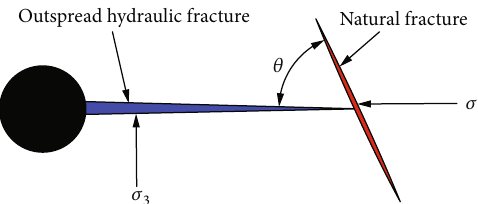
Figure 2: Plane model of a hydraulic fracture intersecting a natural fracture.